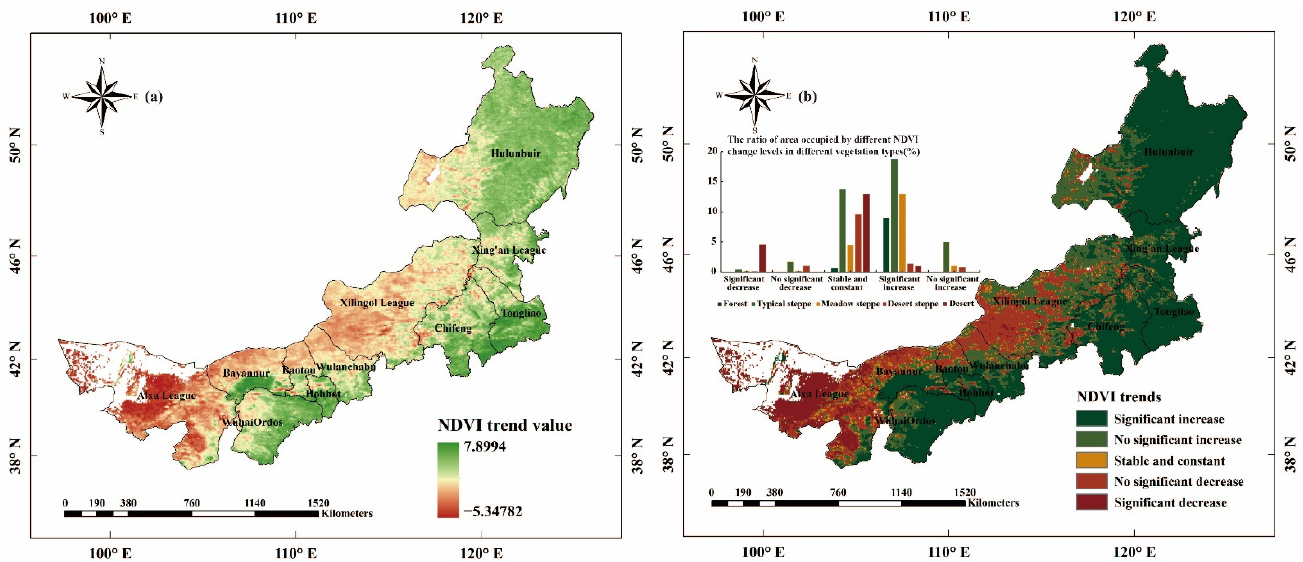
Figure 8. Spatial distribution of NDVI trends in Inner Mongolia from 1982 to 2020. ( a ) NDVI trend value, ( b ) multi-year average NDVI trend levels.